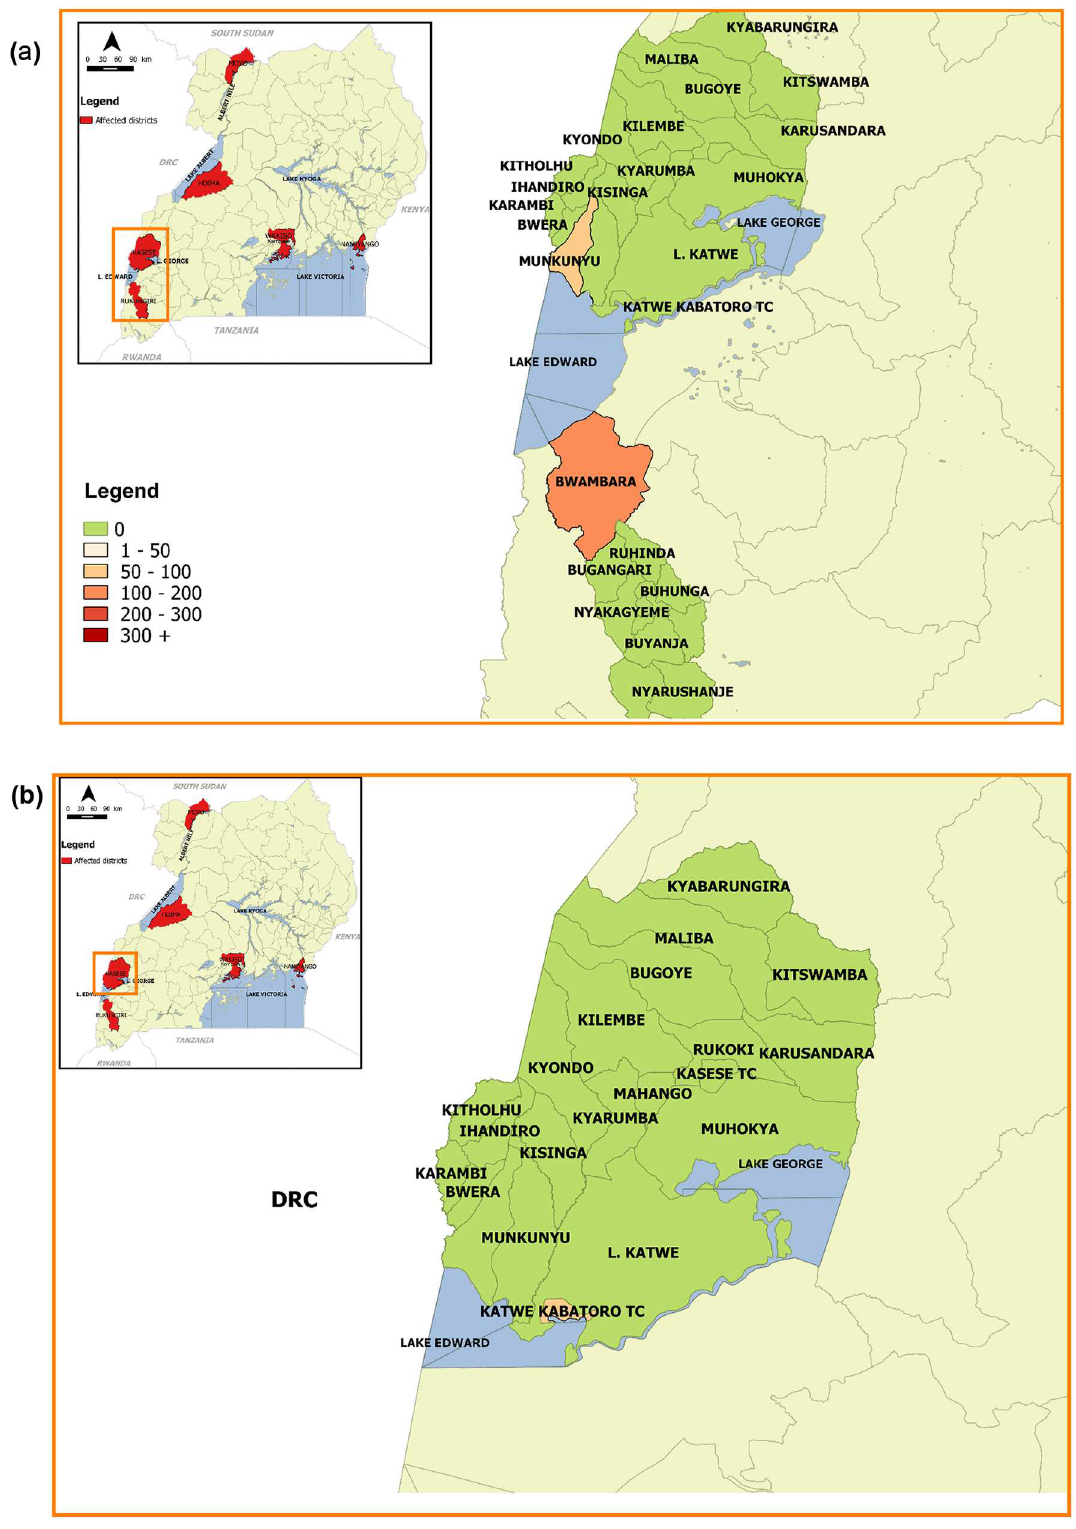
Fig 3. Cholera outbreaks that occurred in fishing villages along Lake Edward. Fig 3a: Choleraoutbreaks in Rukungiri and Kasese districts, 2011; Fig 3b: Choleraoutbreak in Kasese district, 2015.